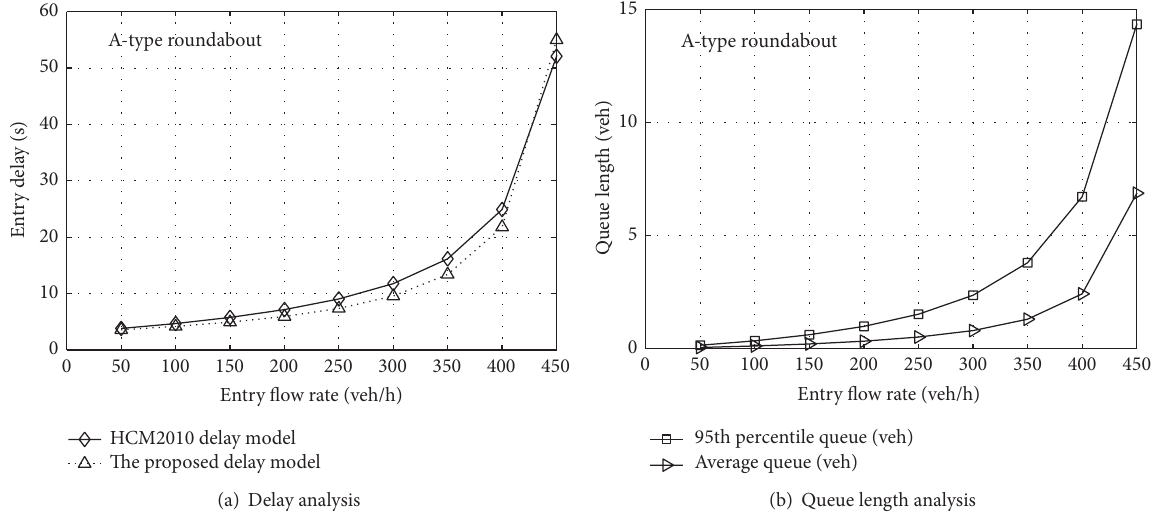
Figure 4: The traffic operations quality of the A-type roundabout.